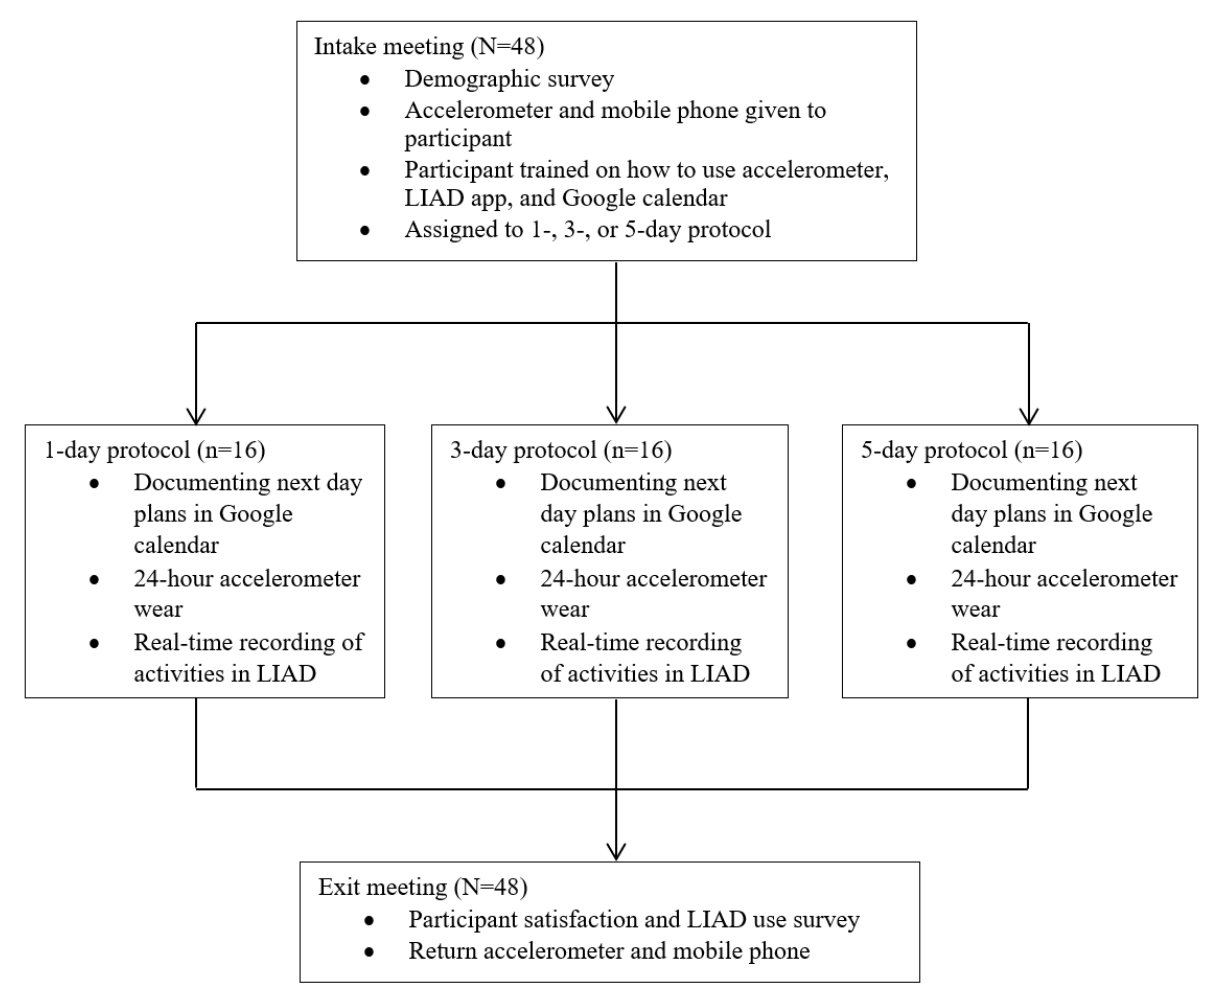
Figure 1. Study flow. LIAD: Life in a